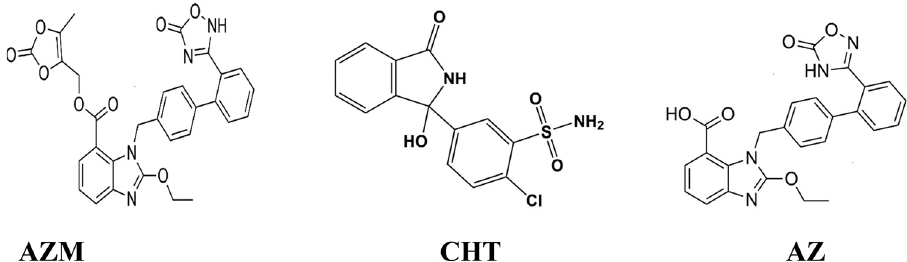
Figure 1: Chemical structure of AZM, CHT, and